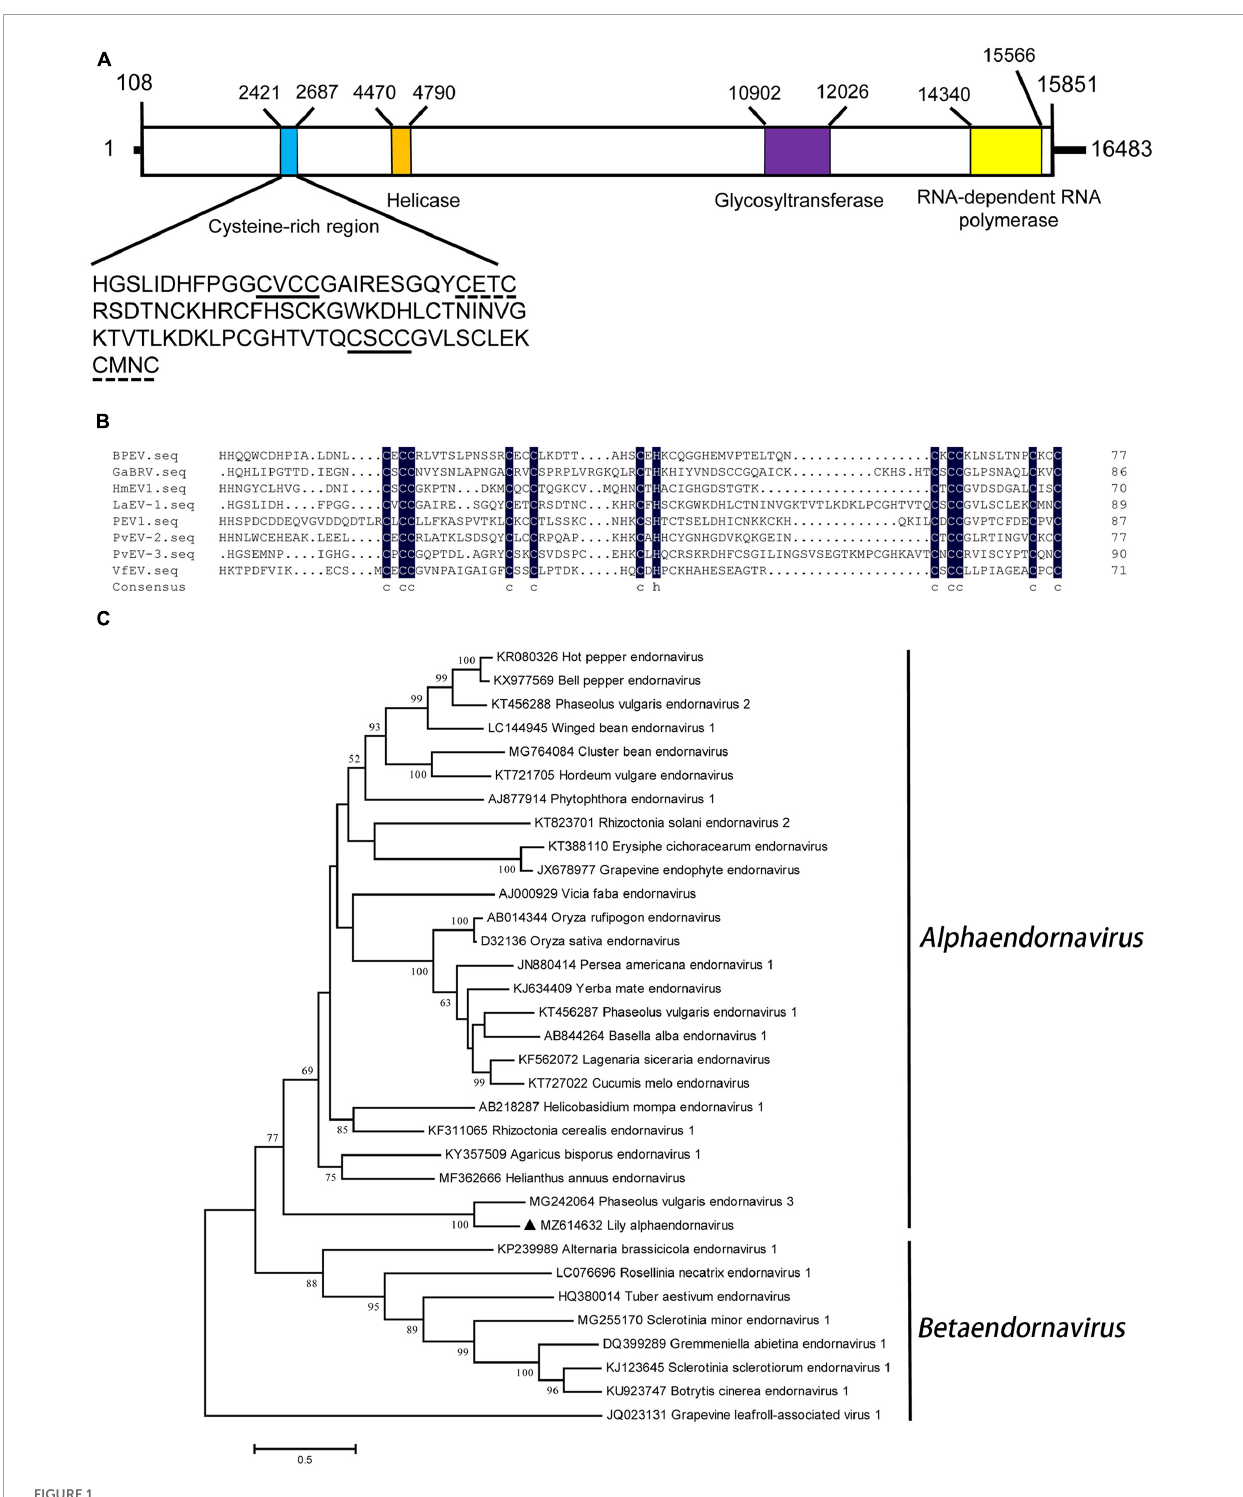
FIGURE1 (A) Schematic representation of the genomic organization of lily-associated alphaendornavirus 1 (LaEV-1). The nucleotide positions of the protein domain sites were listed. The large box represents the polyprotein encoded by LaEV-1, and the small colored boxes represent the cysteine-rich region (CRR) (blue), whose sequence was presented, helicase domain (orange), glycosyltransferase domain (purple), and RNA-dependent RNA polymerase (RdRp) domain (yellow), respectively. (B) Multiple alignment of CRR encoded by LaEV-1 and several other characterized endornaviruses. The sequence of the CRR contains two CxCC signatures marked with solid line, and two signatures marked with dotted line, of which the cysteine at the third character in CxCC signature was substituted. BPEV, bell pepper endornavirus; GaBRV, gremmeniella abietina type B RNA virus; HmEV, helicobasidium mompa endornavirus 1; VfEV, vicia fava endornavirus; PvEV-2, phaseolus vulgaris endornavirus 2; PvEV-3, phaseolus vulgaris endornavirus 3. (C) Phylogenetic analysis of the endornaviruses based on the amino acid sequences of RdRp constructed with the maximum-likelihood (ML) method with 1,000 bootstrap replicates. Grapevine leafroll-associated virus 1 was selected as outgroup. Bootstrap values are given by numbers at the relevant nodes in the topology and only bootstrap values of ≥ 50% were shown. LaEV-1 was indicated with solid black